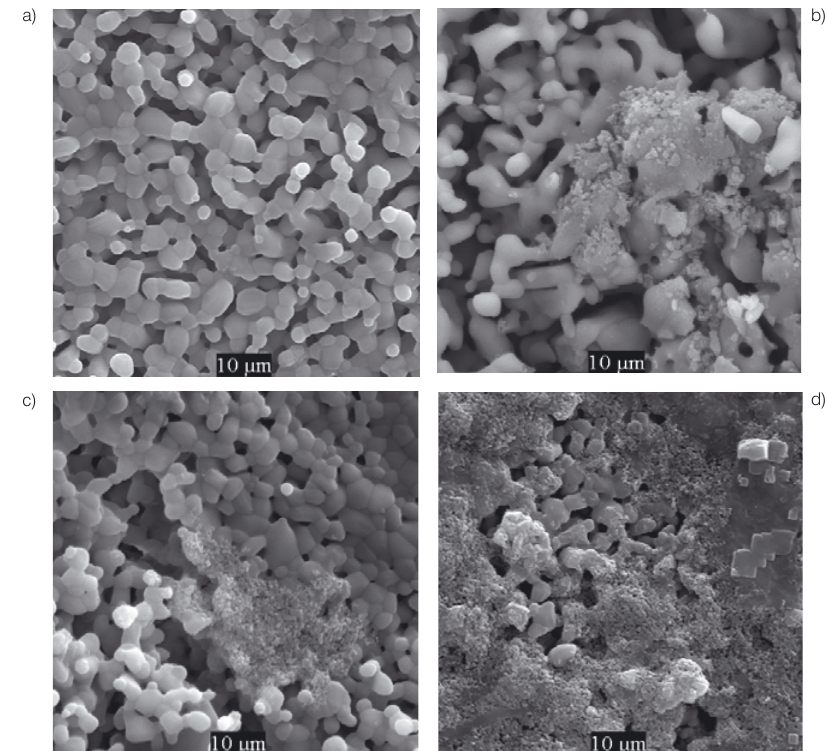
Figure 3. Surface microstructure of FHA: a) before immersion in SBF, b) after 48 hours in SBF, c) after 1 week in SBF, d) after 4 weeks in SBF.